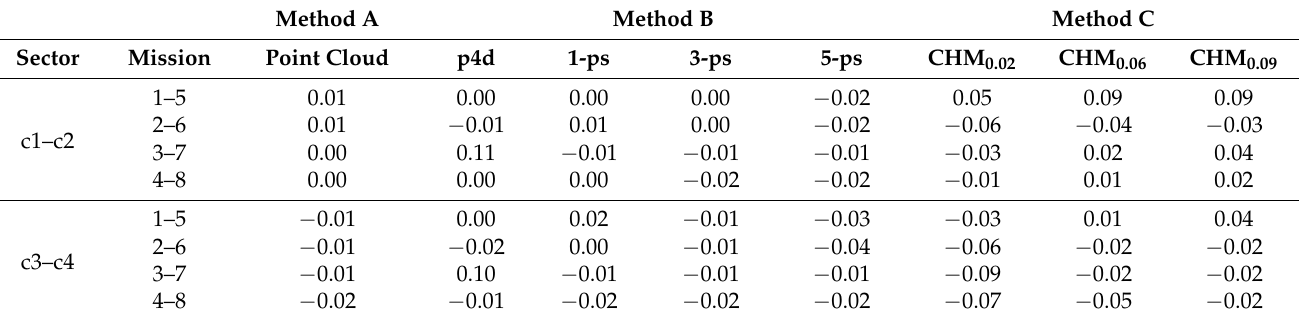
Table 9. Deviations between field measurements and trial calibration values according to methods A, B, and C. For Method B, p4d corresponds to photogrammetric-processing-derived DSM and the rest for LiDAR-processing DSM, indicating the corresponding spatial resolution (ps: point spacing). For Method C, the CHM subindex indicates the spatial resolution. Values are in m. Method A Method B Method